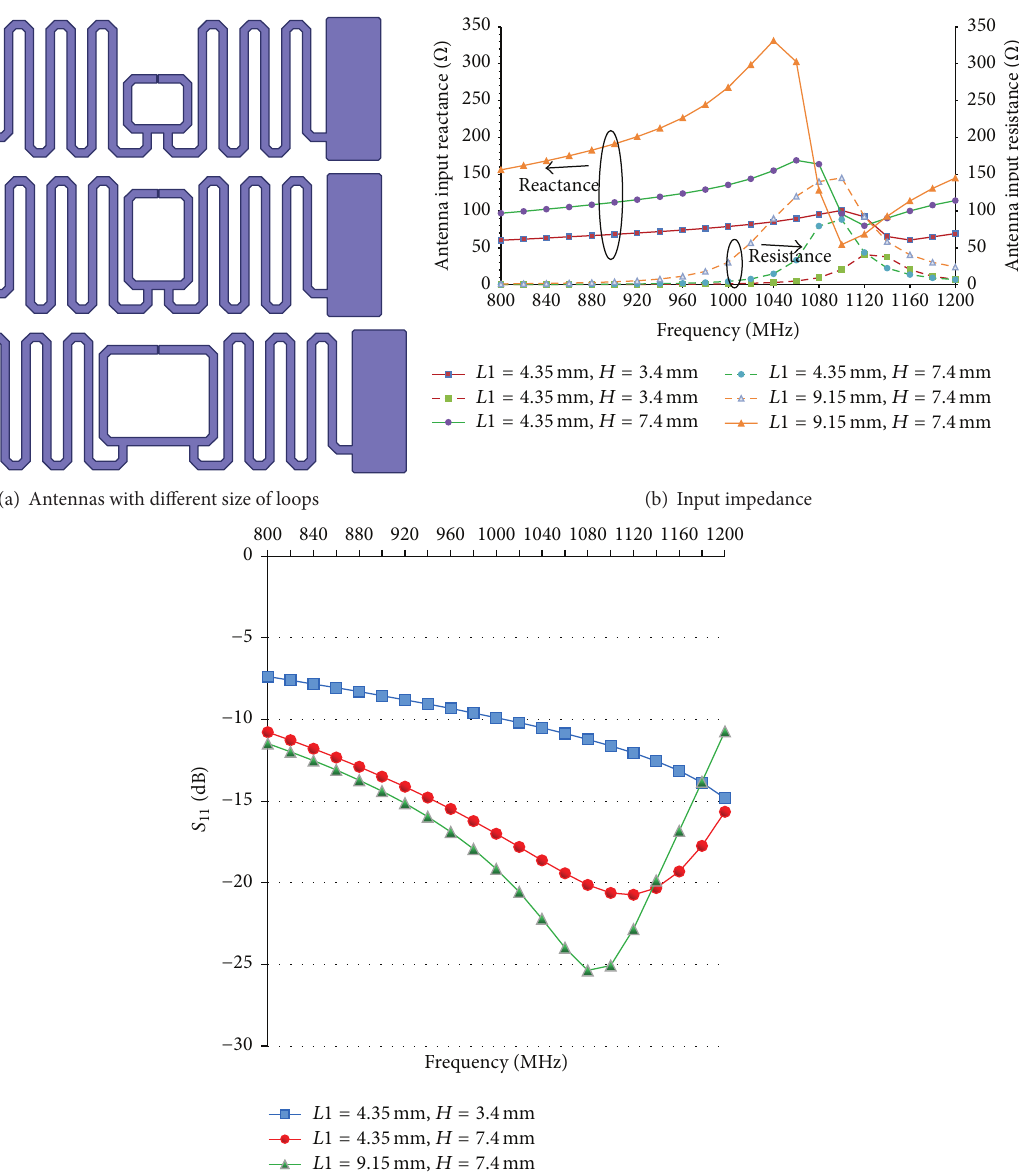
Figure 5: Simulated input impedance and reflection coefficients of tag antenna with different loops.